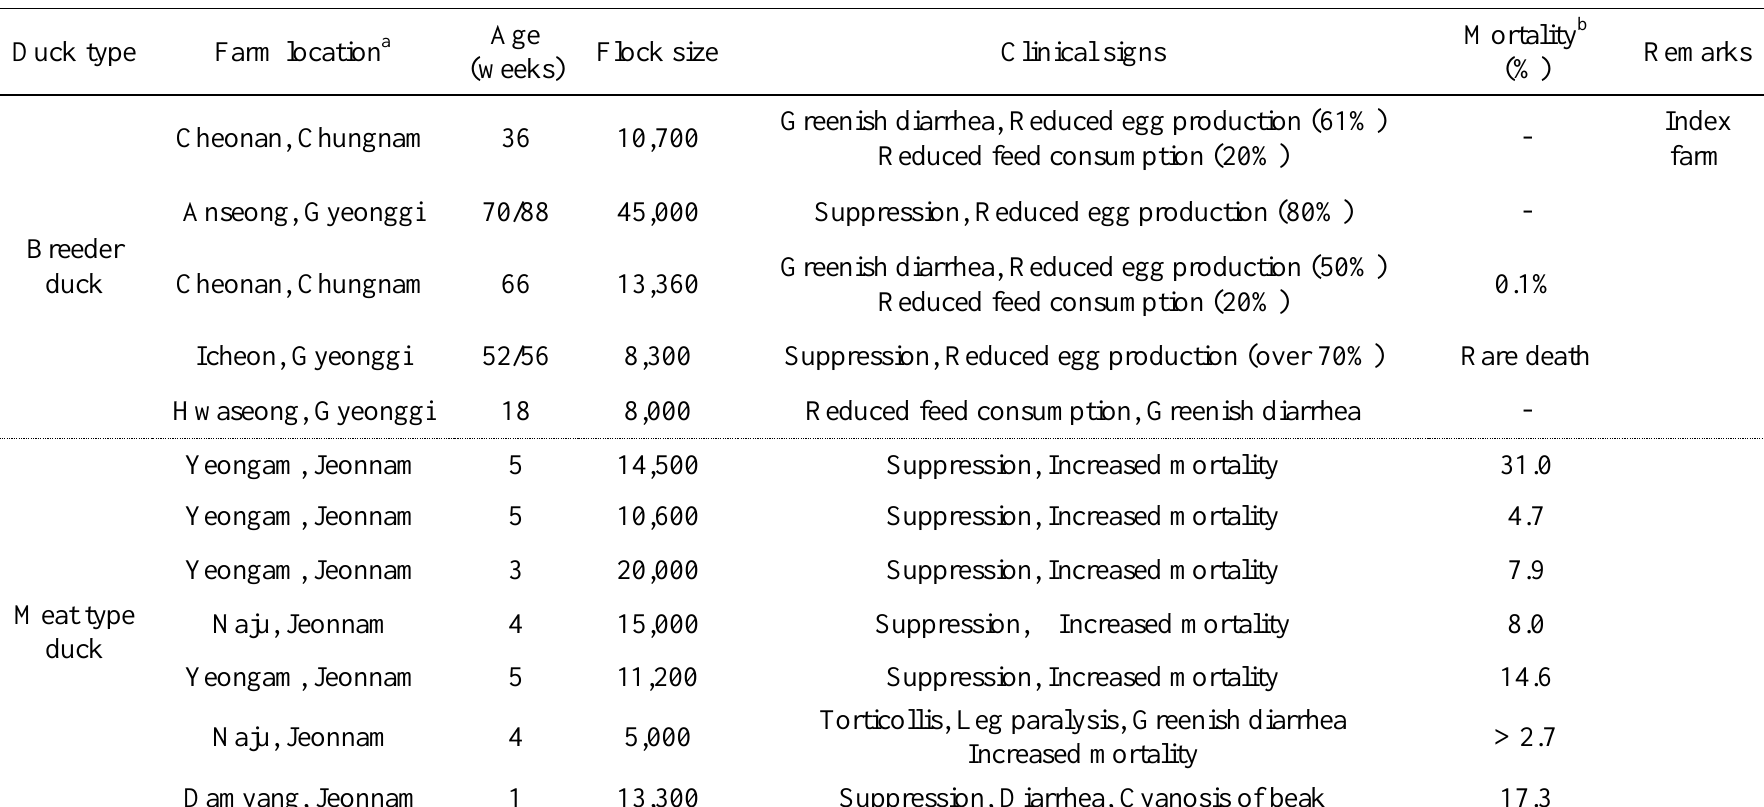
Table 1. Disease situation of selected highly pathogenic avian influenza (HPAI) virus-infected domestic duck farms during the 2010/2011 H5N1 HPAI outbreak in